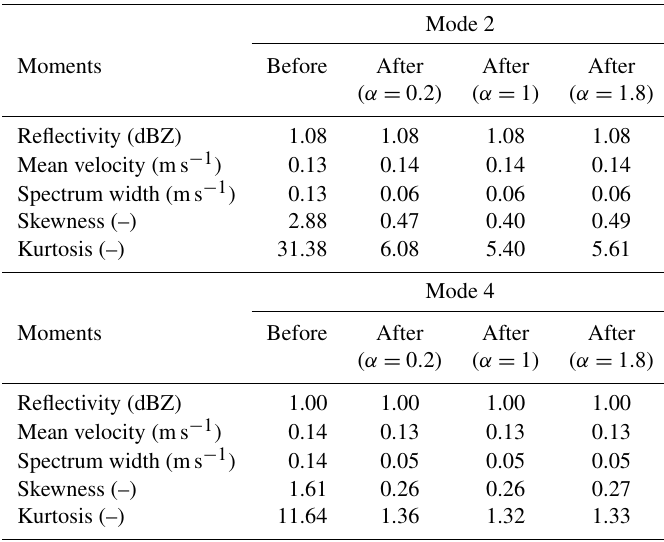
Before After After